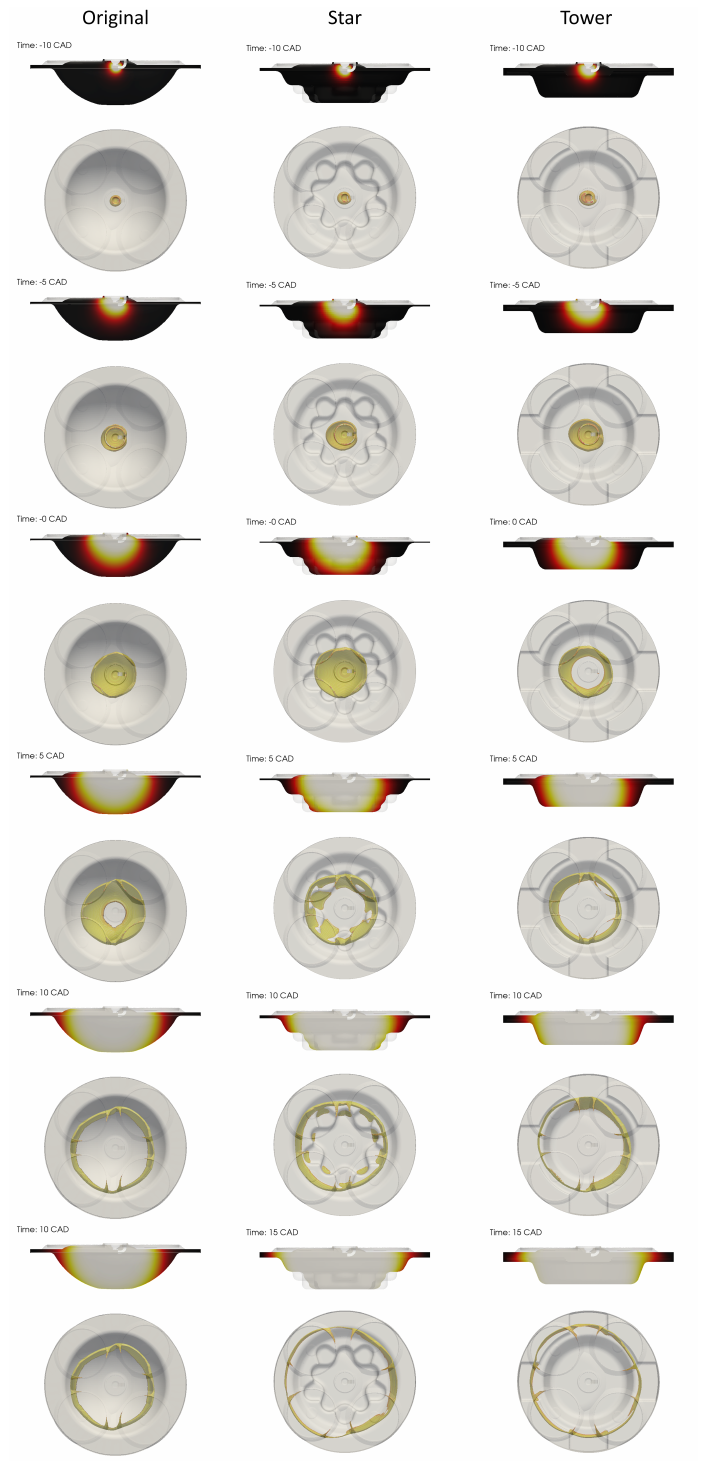
Figure 13. Flame propagation process for the B50 operating condition when using the three different piston bowl geometries. On top of each sub-figure, the temperature field is visualized on a plane passing through the spark plug’s center. On the bottom of each sub-figure, an iso-surface with b = 0.5 is